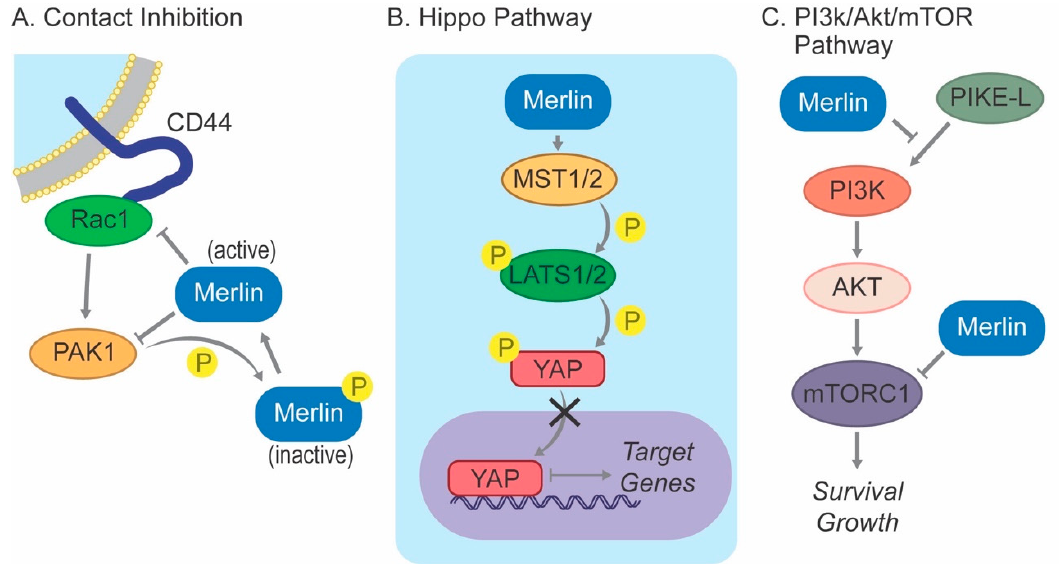
Figure 2. Merlin signaling. ( A ) Active, de-phosphorylated Merlin inhibits Rac1 and PAK1, key mediators of contact inhibition; ( B ) Merlin activates the Hippo pathway, leading to YAP phosphorylation and its sequestration from the nucleus; ( C ) Merlin is a negative regulator of PIKE-L and mTORC1.